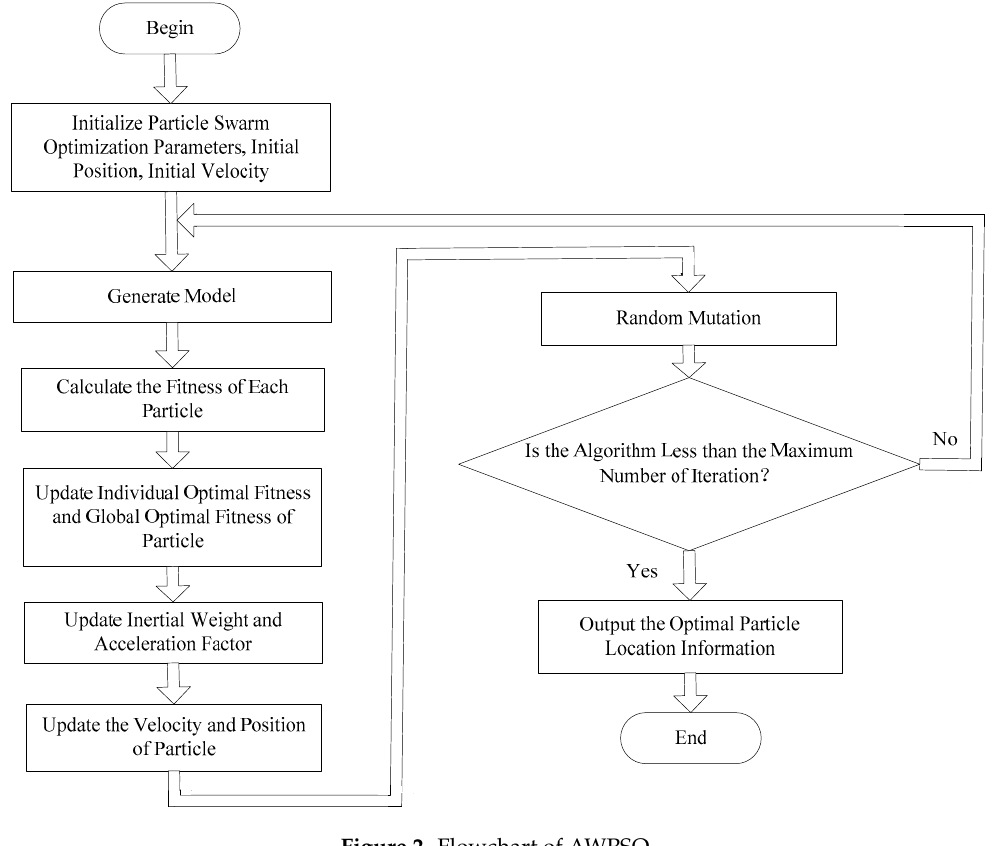
Figure 2. Flowchart of AWPSO.